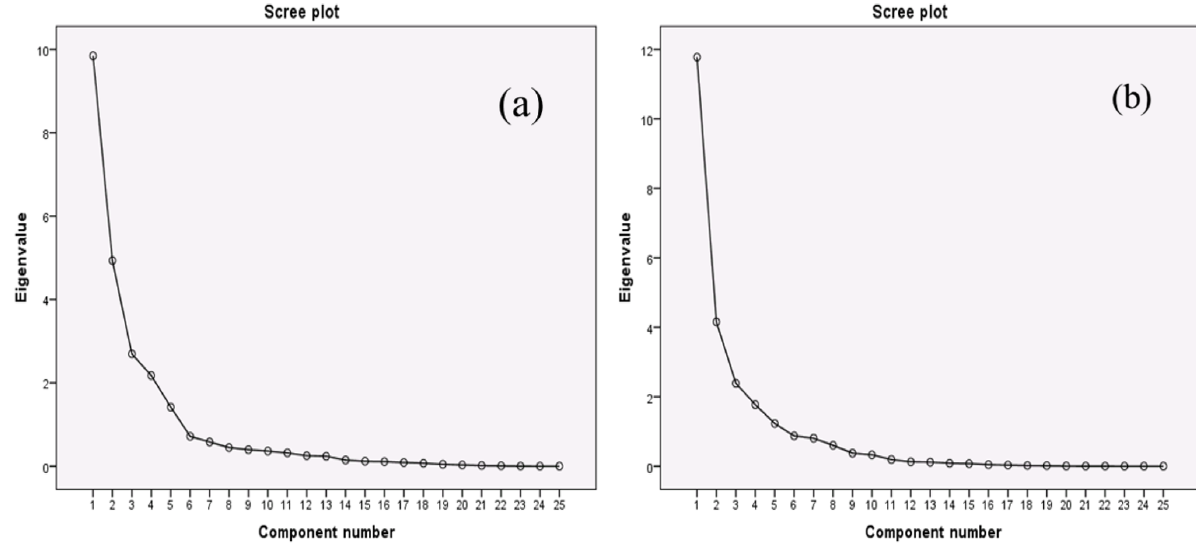
Figure 8. Scree plots. Note: (a) : Model 1. (b) : Model 2. Table 4. Summary of PCA.